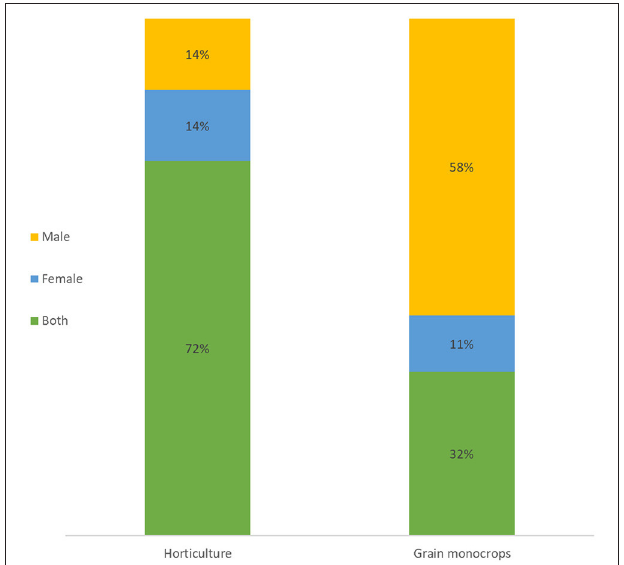
FIGURE 2 | Decision-making by farming system type (horticulture vs. grain monocrops), comparing whether male farmers, female farmers, or both (joint management) were the primary decision makers. The proportion of primary decision makers who were either male farmers or “both” male and female farmers was significantly different between horticulture and grain monocrops ( p -value < 0.05). FIGURE 3 | Decision-making by households participating, and not